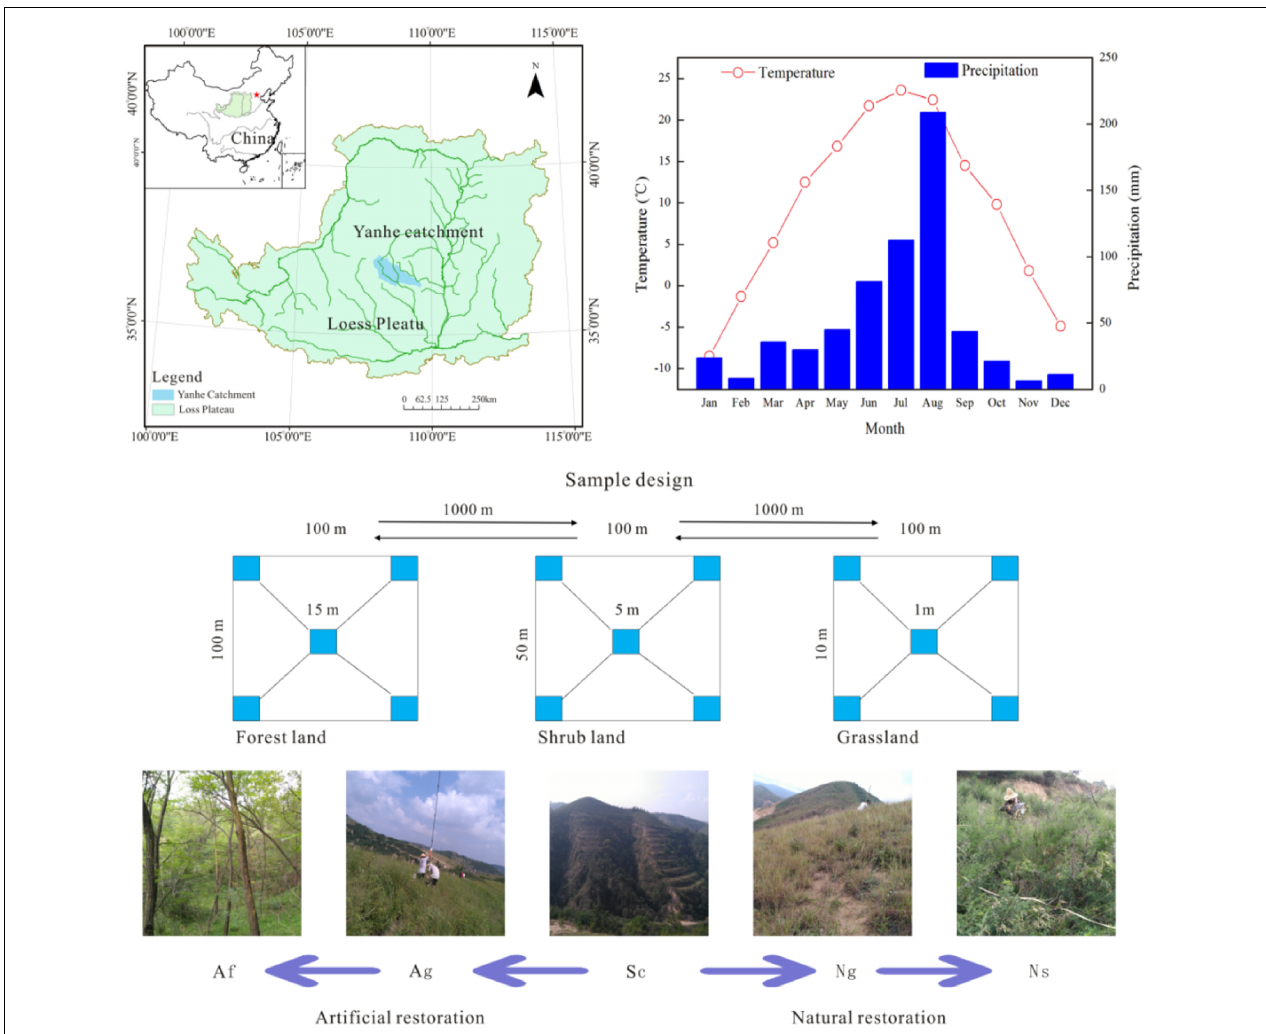
FIGURE 1 | Location of the study area and layout of the plots among the different land use types. The pictures were generated by ArcMap Version 10.2 (http://www.esri.com/). These pictures were photographed by the authors in the Yanhe catchment during July 2016. Af, Artificial forest; Ns, Natural shrub; Ag, Artificial grassland; Ng, Natural grassland; Sc, Slop